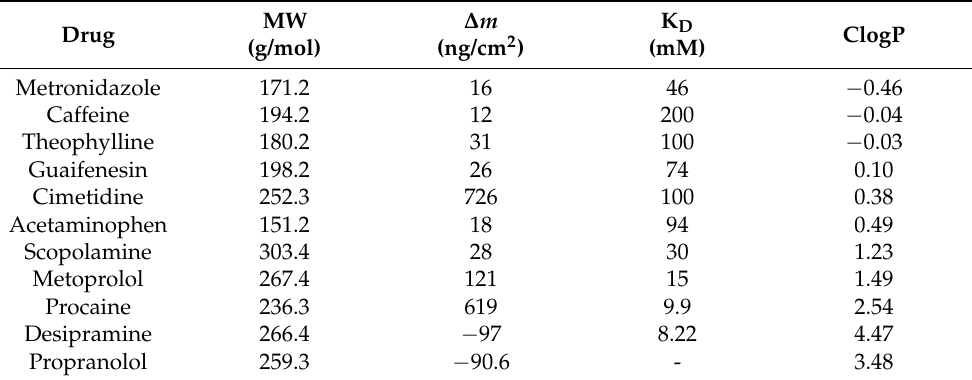
Table 1. Mass measurements (QCM), binding constants, molecular weight, and ClogP hydrophobici- ties of the